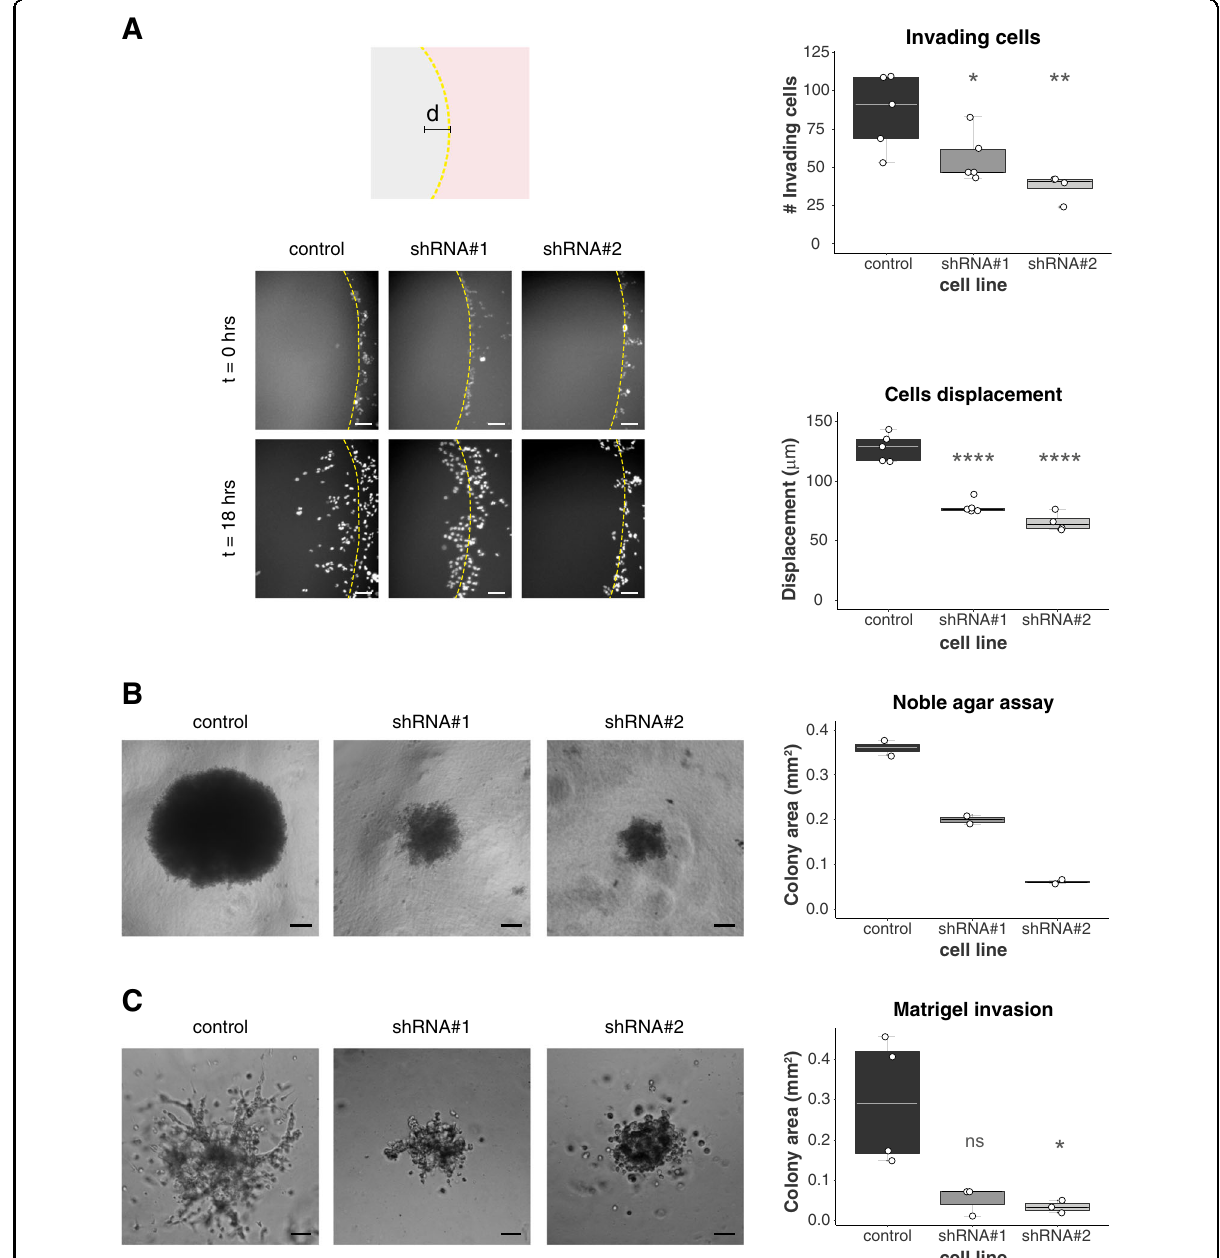
Fig. 3 USP19 knockdown reduces cellular invasion. A Top left: Diagram of agar spot assay. MDAMB231 cells were seeded in wells (pink surface) with drops of solidi fi ed agar (gray sphere) and allowed to invade along the bottom surface under the agar. Pictures were taken along the edge (the edge is indicated by a dotted line); the displacement (d) is the extent of invasion under agar from the spot edge until the end of the experiment. Bottom Left: Representative area showing cell invasion into an agar spot at the indicate time points. Top right: Quanti fi cation of the mean number of invading cells per spot ( n ≥ 4, one-way ANOVA, Dunnett ’ s multiple comparison test. shRNA#1 p = 0.0497 and shRNA#2 p = 0.0042) and bottom right: cells mean displacement after 18 h ( n ≥ 4, one-way ANOVA, Dunnett ’ s multiple comparison test. shRNA#1 p < 0.0001 and shRNA#2 p < 0.0001). Scale bar = 100 μ m. B Noble agar assay was used to study 3D culture proliferation and invasion. Left: Representative bright fi eld images obtained at 6 weeks in culture are shown. Scale bar = 150 μ m. Right: Colony size was calculated at the end of the experiment ( n = 2). C Left: Representative area showing cell invasion in a Matrigel 3D experiment after 5 days in culture. Right: Colony area was calculated at the end of the experiment ( n ≥ 3, Kruskal – Wallis, Dunn ’ s multiple comparison test. shRNA#1 p = 0.1033 and shRNA#2 p = 0.0348). Scale bar = 150 μ